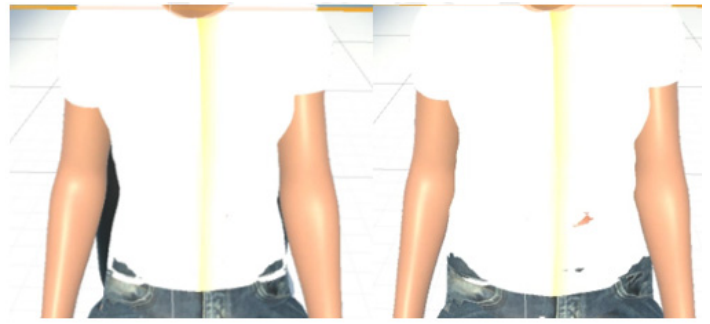
Figure 6. ( Left ) visualization of the exhalation ( Right ) visualization of the inhalation.